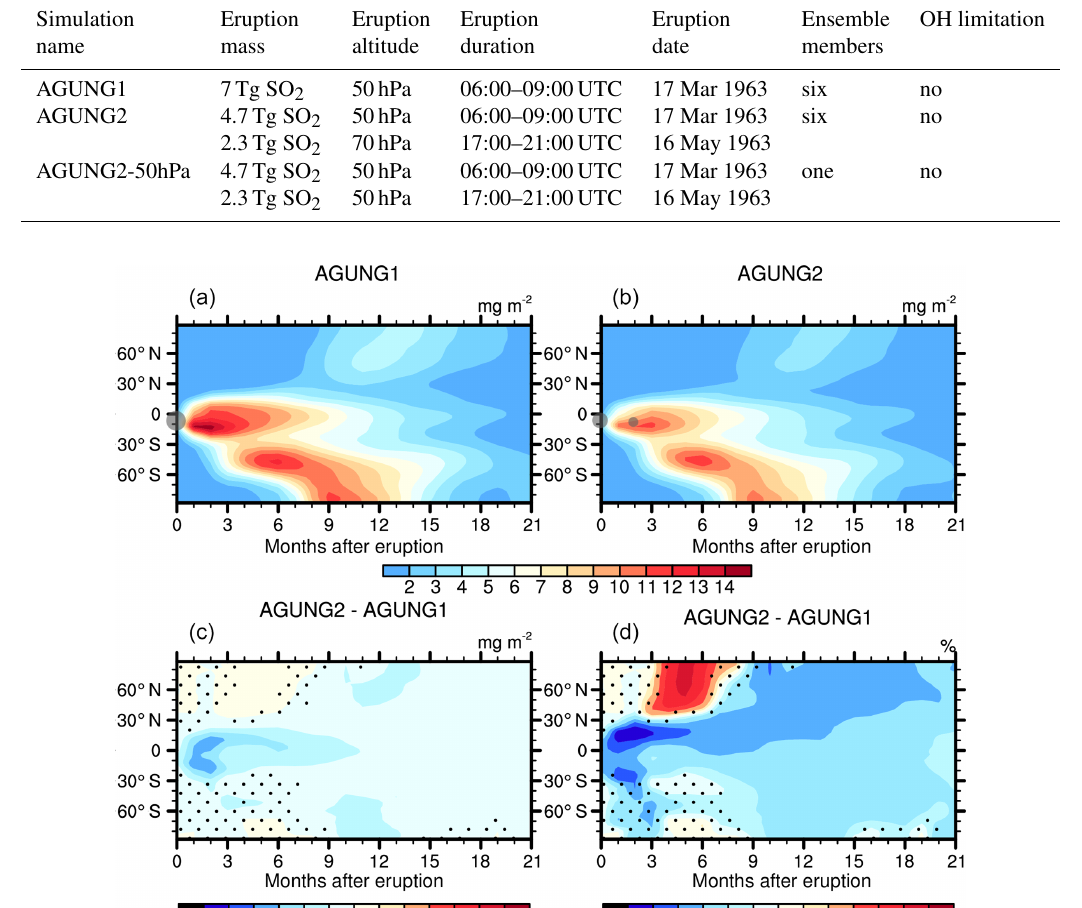
Table 1. Overview of the performed simulations and information to the eruption details, after Self and Rampino (2012).